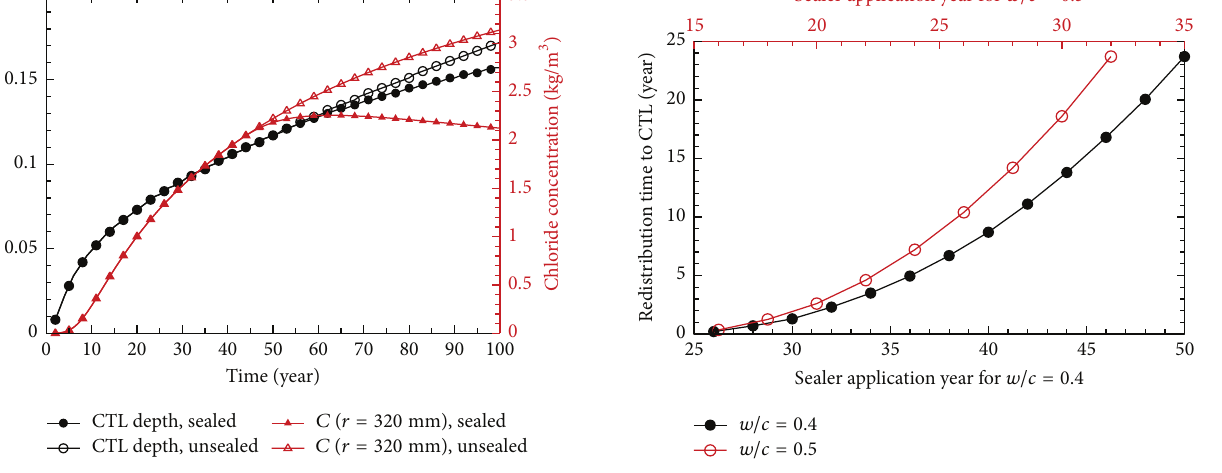
Figure 10: Time taken to redistribute chloride concentrations inside a sealer to be less than or equal to the CTL (1.2 kg/m 3 ). For all samples, the sealer application was applied at the minimum cover depth (80mm). 𝑅 = 0 . 4